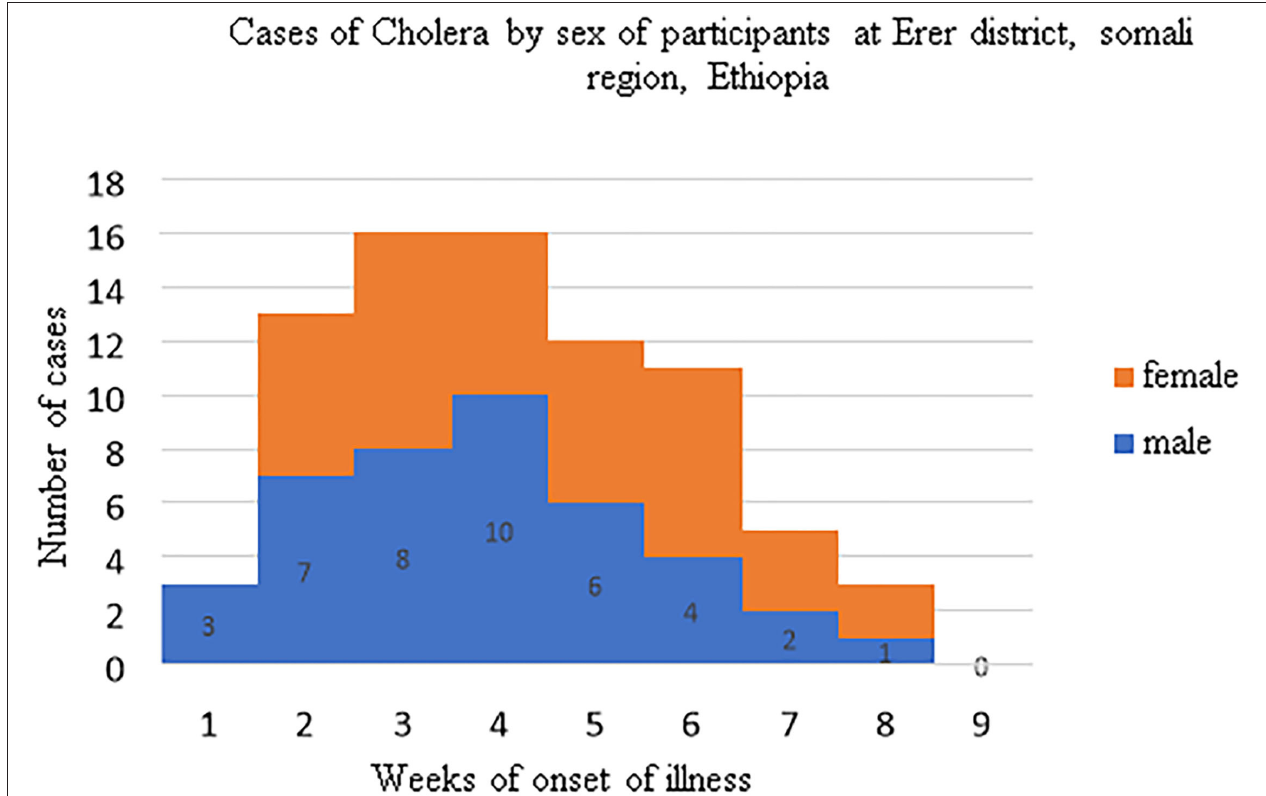
FIGURE 3 | Epicurve showing the distribution of cholera illness based on the sex of